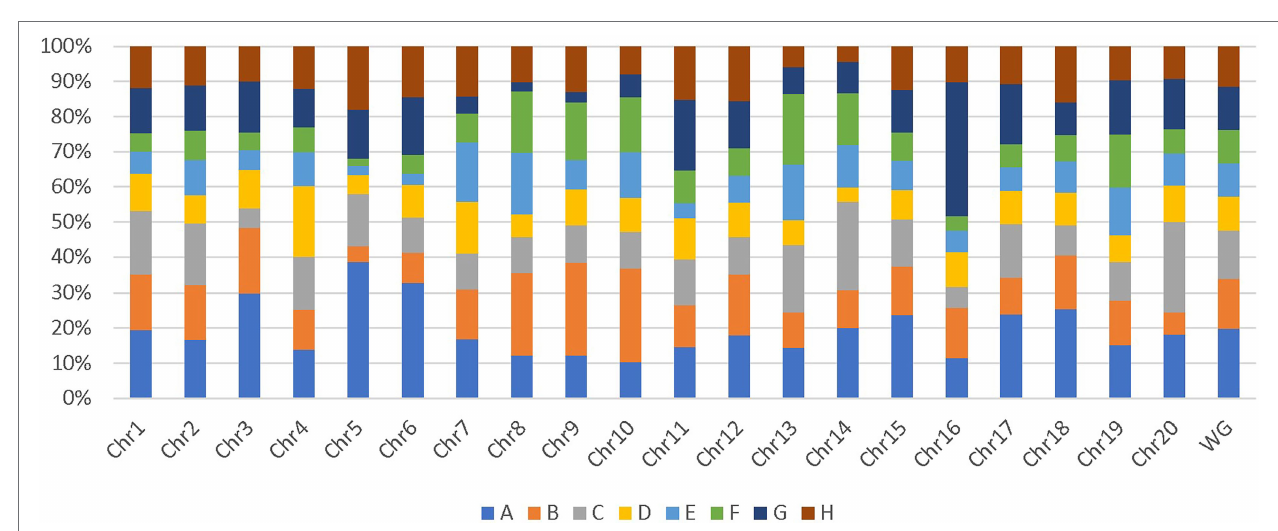
FIGURE 5 | Chromosome-wide and genome-wide allele contribution of parental lines. WG represents the contribution of parental lines in whole